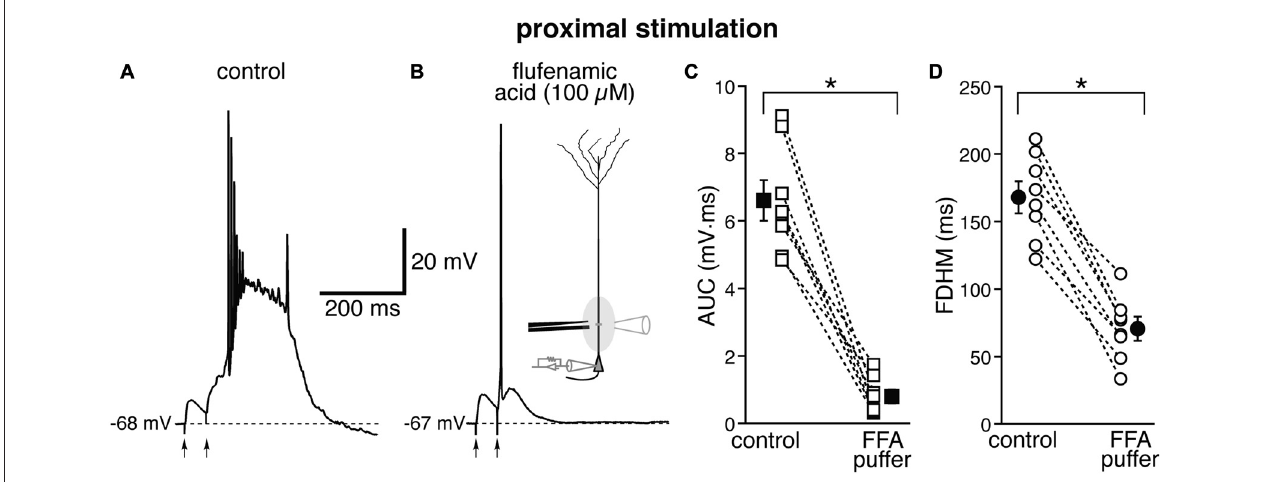
FIGURE 7 | Local perfusion of FFA abolishes burst firing for proximal stimulation. Representative trace of the response elicited by proximal synaptic stimulation in control conditions (A) and when FFA (100 µ M, B ) was locally applied through a ruptured pipette connected to a picospritzer; the inset in (B) shows a diagram of the experimental configuration. In seven out of eight neurons, local perfusion of FFA changed the postsynaptic suprathreshold response from a burst into a single AP. This effect of FFA is reflected in the marked average decrease of the AUC ( C , by 87 ± 4%) and the FDHM ( D , by 58 ± 4%). Asterisks indicate significant difference between control conditions and local FFA